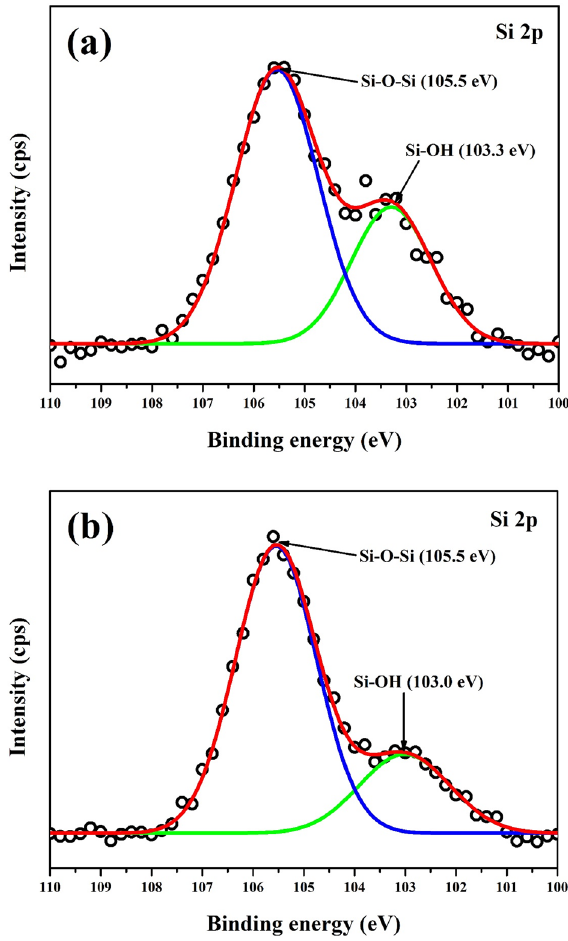
Figure 7. XPS spectra of Si 2p for ( a ) LAPC-1 and ( b )